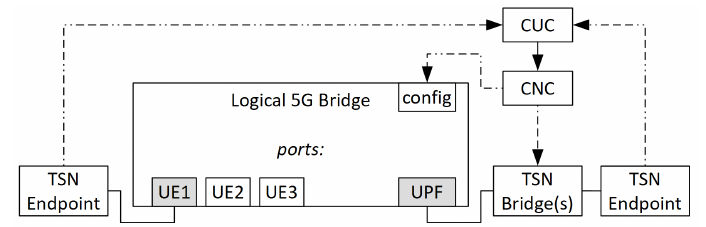
Figure 3. Bridge representation of a 5GS.